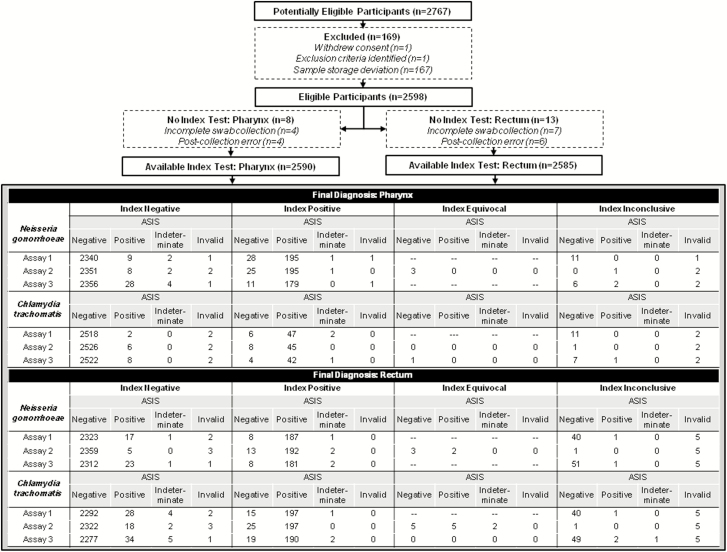
Standards for Reporting of Diagnostic Accuracy Studies diagram of participant flow. Abbreviation: ASIS, anatomic site infected status.